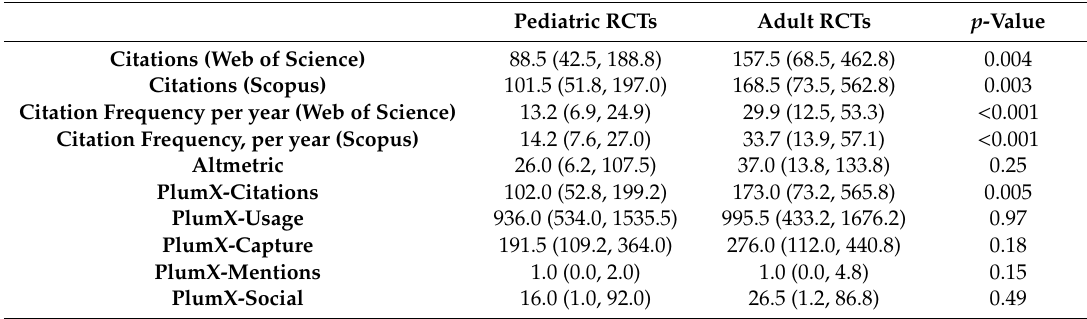
Table 4. Measures of academic and non-academic impact in pediatric RCTs and adult